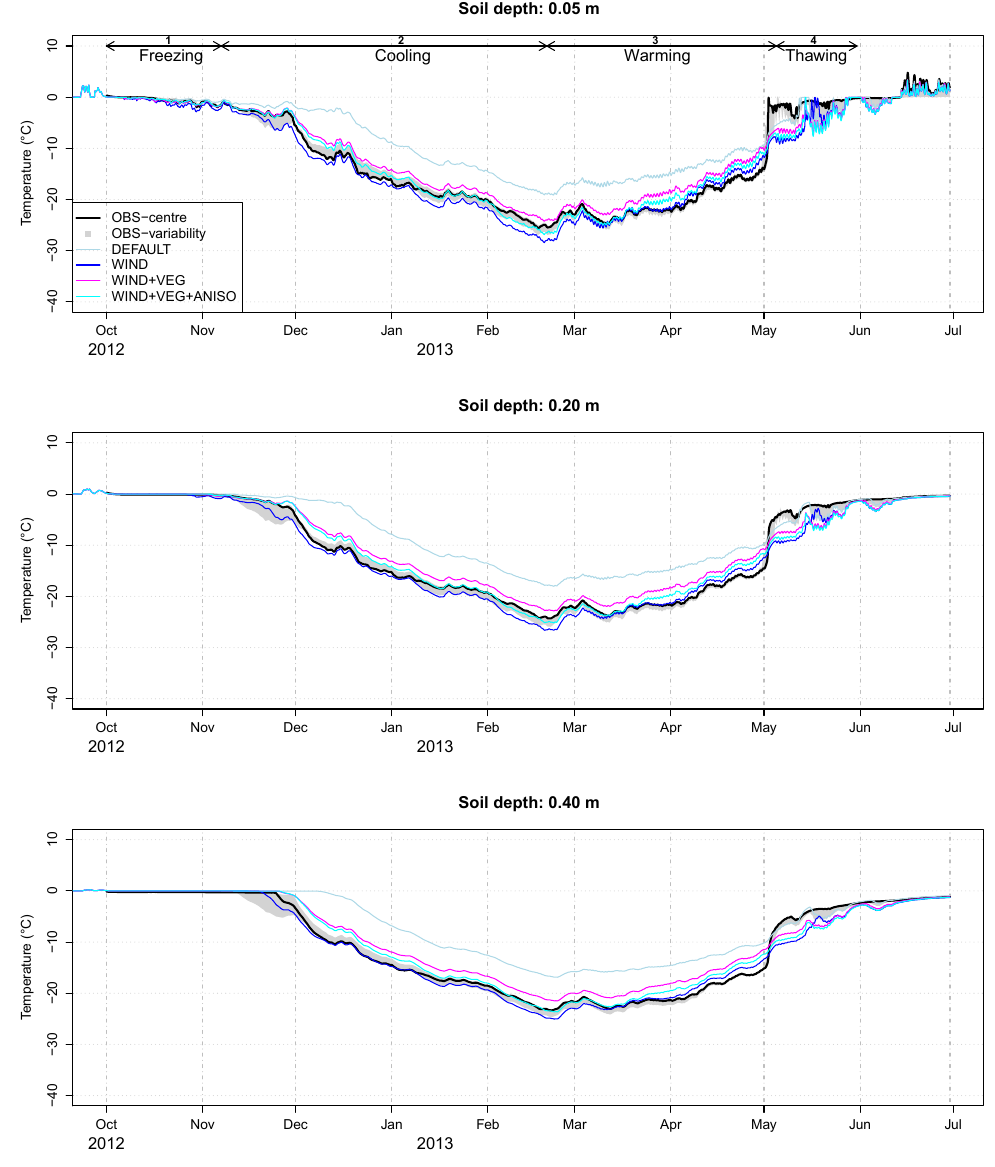
Figure 8. Simulated vs. observed soil temperatures at depths of 5, 20, and 50cm in the reference polygon’s grass centre. OBS variability (grey shading) is the envelope of observed soil temperatures from the monitored rim, centre, and slope soil sites. The winter phases from Sect. 5.2 have been